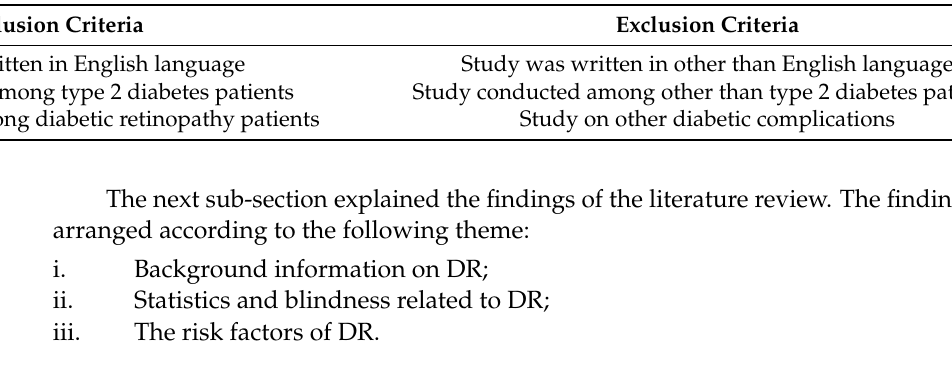
Table 1. Inclusion and exclusion